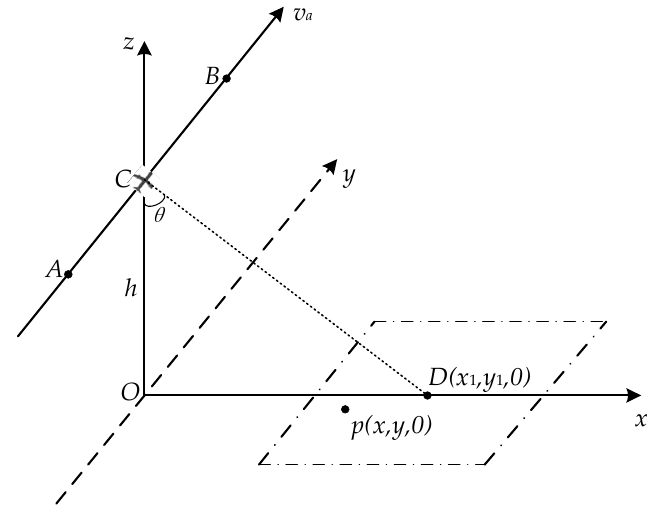
Figure A1. Geometric relationship of single-view airborne SAR imaging.